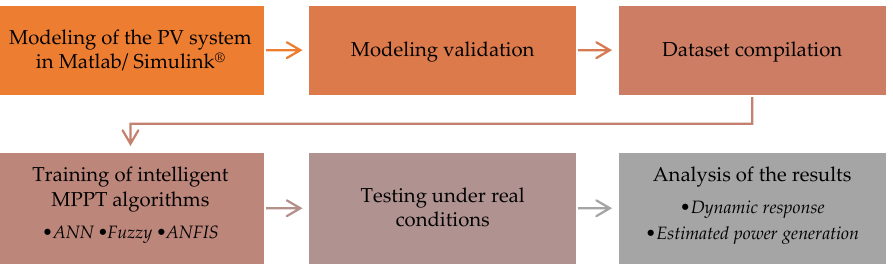
Figure 5. Stages of the methodology.